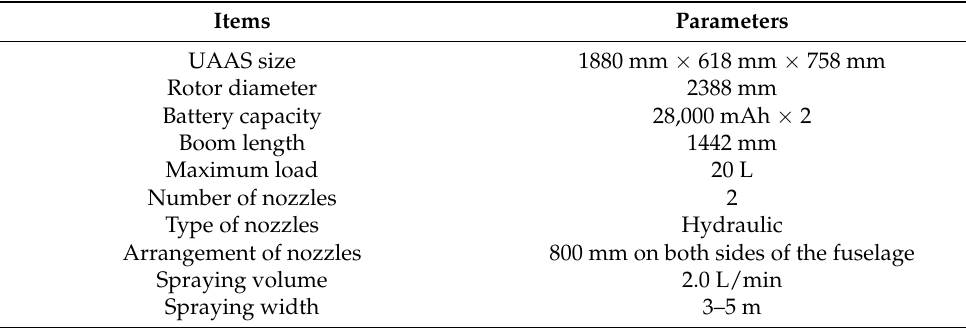
Table 2. The main technical parameters of CE20.